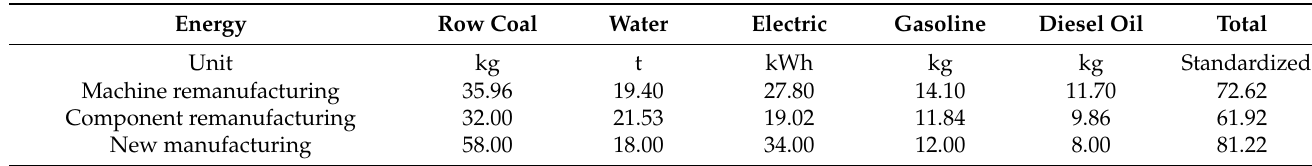
Table 7. Standardization of R c for different remanufacturing strategies.